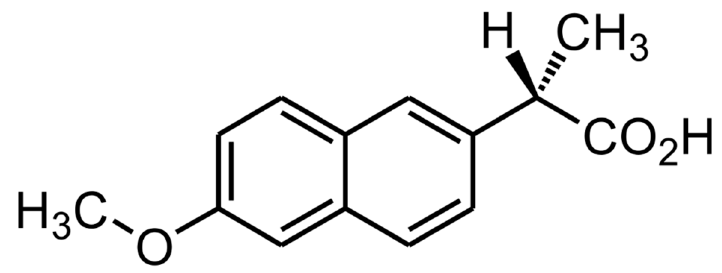
Figure 1. Chemical structure of naproxen (NX).